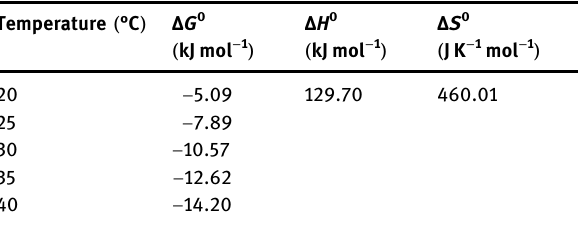
Table 3: Thermodynamic parameters for the adsorption of GPC on resin 001 ×